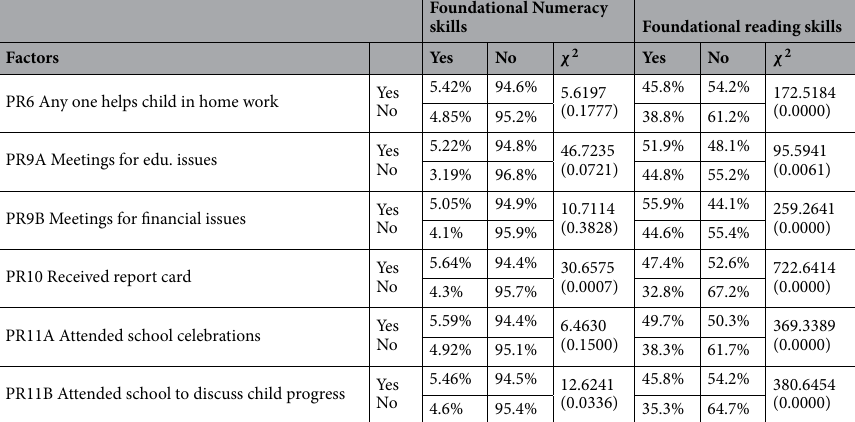
Table 2. Percentage Distribution of Children (Learning Skills × Parental Involvement Factors) in MICS 2018, Punjab. p -value < 0.05 (significant), ( ) = p